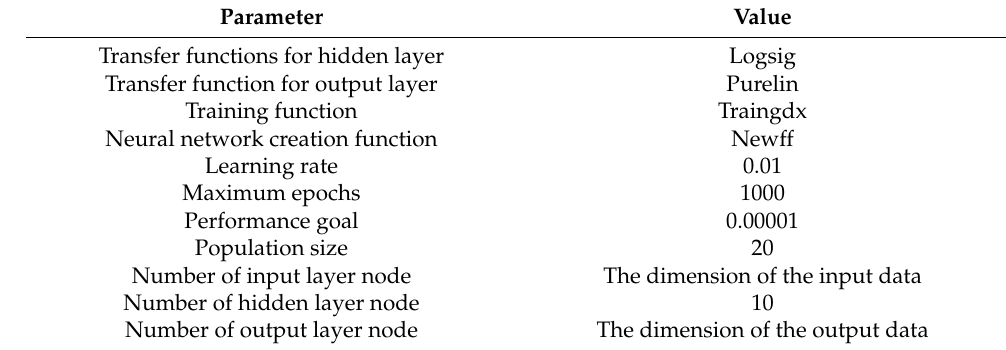
Table 1. The parameters of the